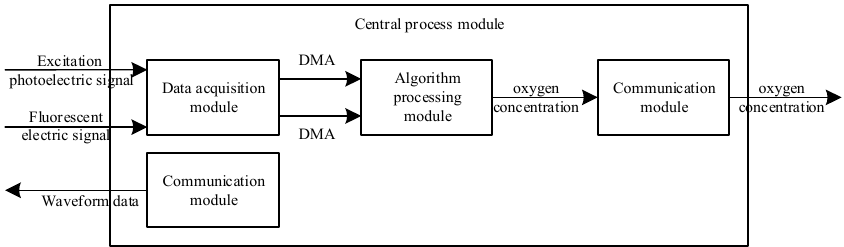
Figure 4. Internal structure diagram of the central processing module.